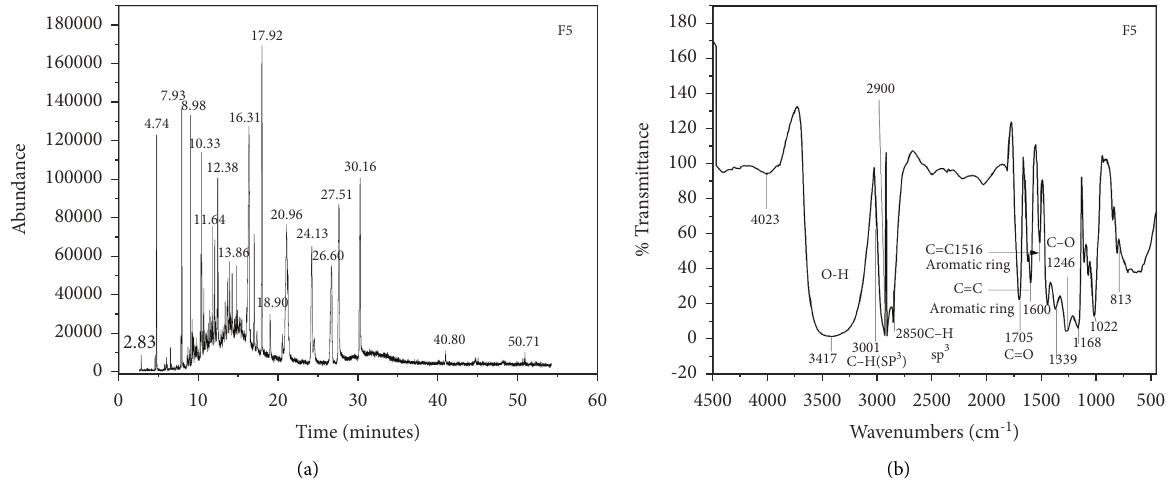
Figure 6: GC-MS chromatogram (a) and FTIR spectrum (b) for fraction F5.